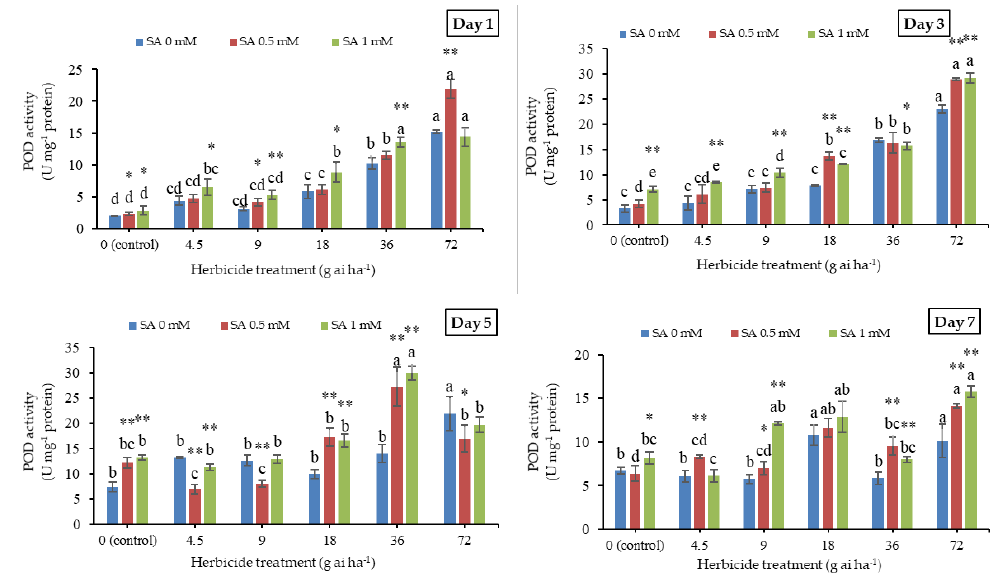
Figure 5. Changes in peroxidase (POD) activity in the leaf tissues of wheat at 1, 3, 5, and 7 days after herbicide application at different rates. The leaves were pre-treated with different concentration of salicylic acid (SA) 3 days prior to herbicide application. The bars represent the treatment mean ± SD ( n = 4), and the bars with different lower-case letters were significantly ( p ≤ 0.05) different , according to the Duncan ’ s test. Asterisks indicate significant difference between the herbicide only and herbicide with each concentration of SA, according to the Independent Samples t -test.